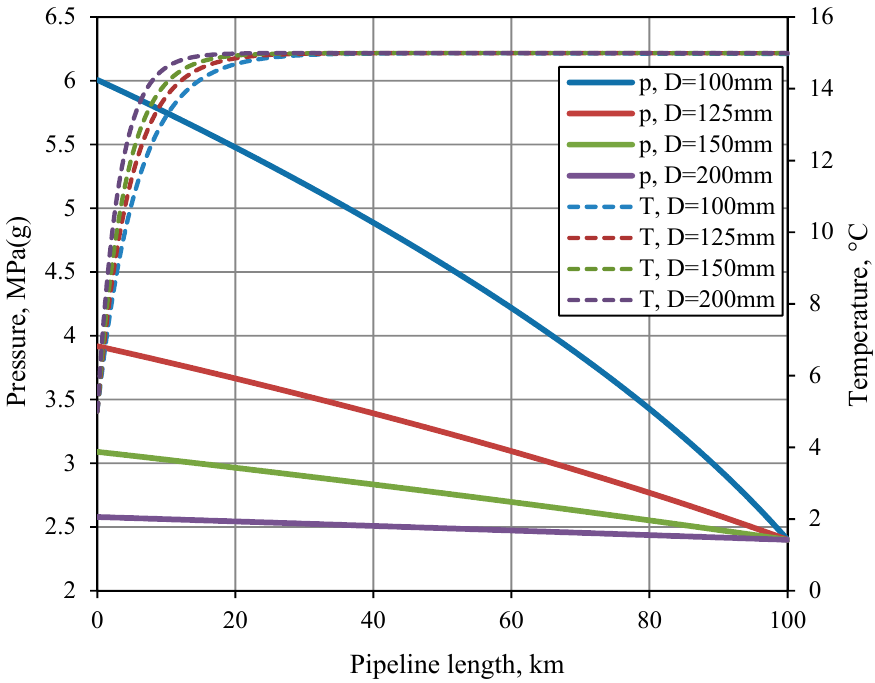
Figure 6. Pressure ( p ) (continuous lines) and temperature ( T ) (dashed lines) changes for hydrogen mass flow rate of 0.3 kg/s (12,000 Nm 3 /h) and different diameters.